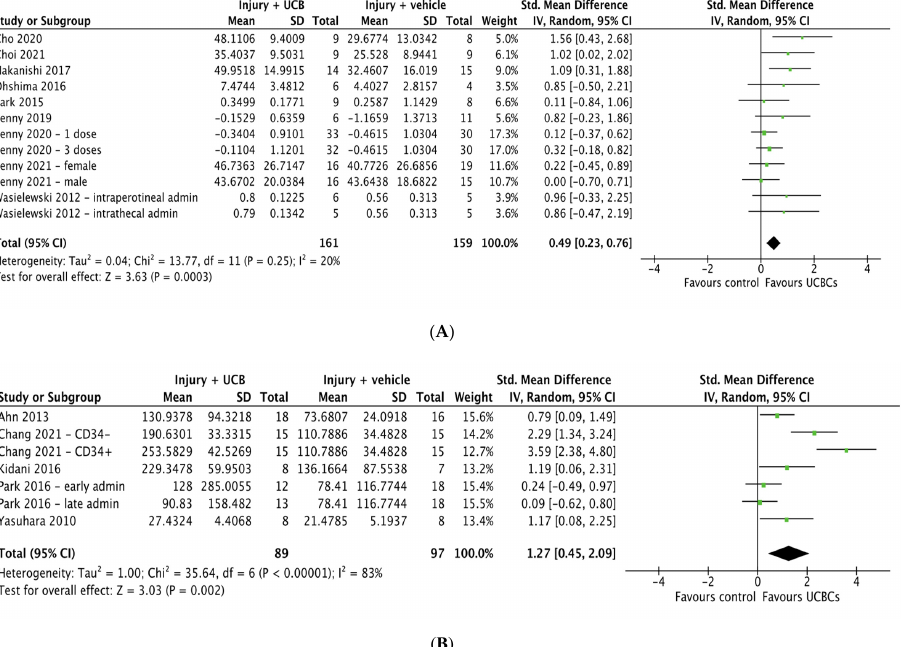
Figure 5. Forest plot demonstrating the effect of umbilical cord blood-derived cell therapy on mo- tor function ( A ) Cylinder test; ( B ) Rotarod test. Umbilical cord blood-derived cell therapy significantly improved motor function as measured by cylinder test ( p = 0.0003) and rotarod test ( p = 0.002) Abbreviations: admin, administration; UCBC, umbilical cord blood cells.